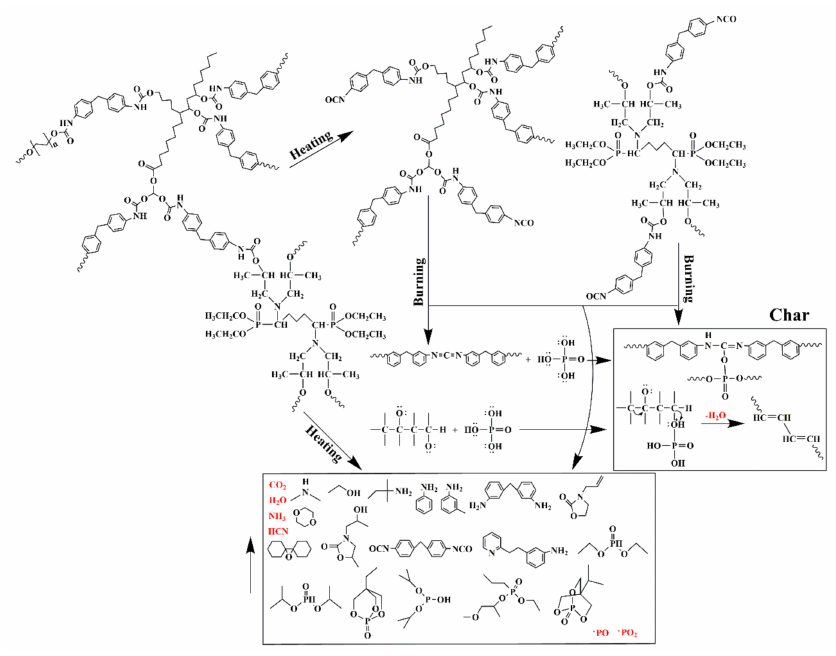
Figure 13. A possible flame–retardant mechanism for RPUFs inserted with TBPBP.